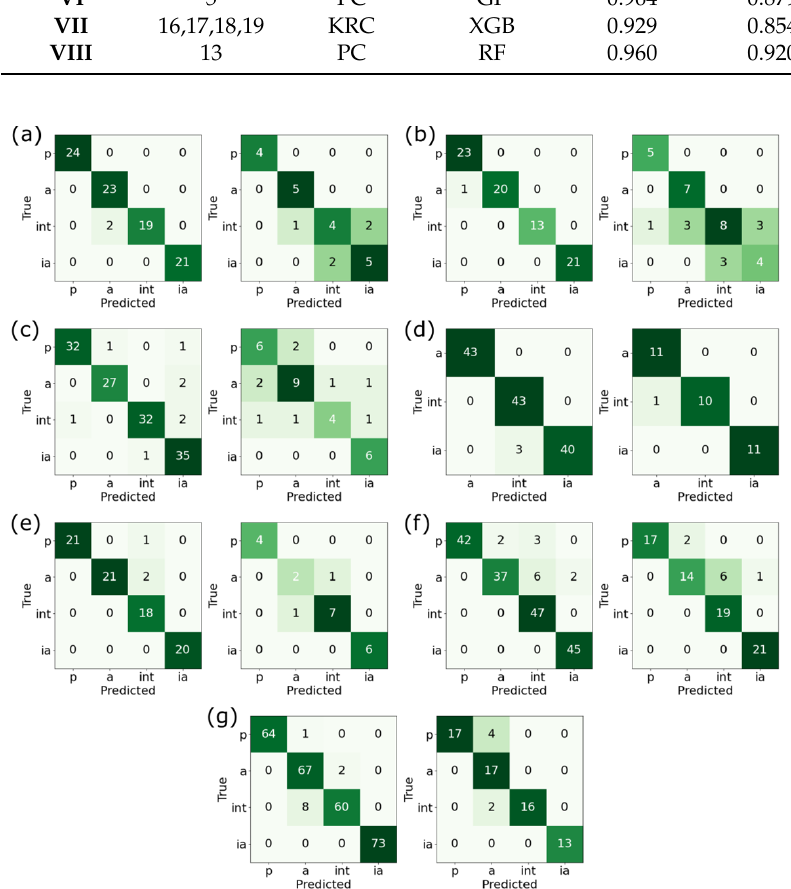
Figure 6. Confusion matrices for the QSAR models of nonsteroidal compounds. ( a – g ) Show the confusion matrices for the training set (left) and for the test set (right) of model II to model VIII, respectively. In comparison with the steroidal compounds (model I), nonsteroidal compounds were fewer in number. While the training performance was quite good overall, the test set confusion matrices in model II, III, and IV had quite large off-diagonal elements, compared with the associated diagonal values. This is also reflected by the accuracy reported in Table 6. Note that model V has no potent compounds. The associated matrices in panel ( d ) are therefore